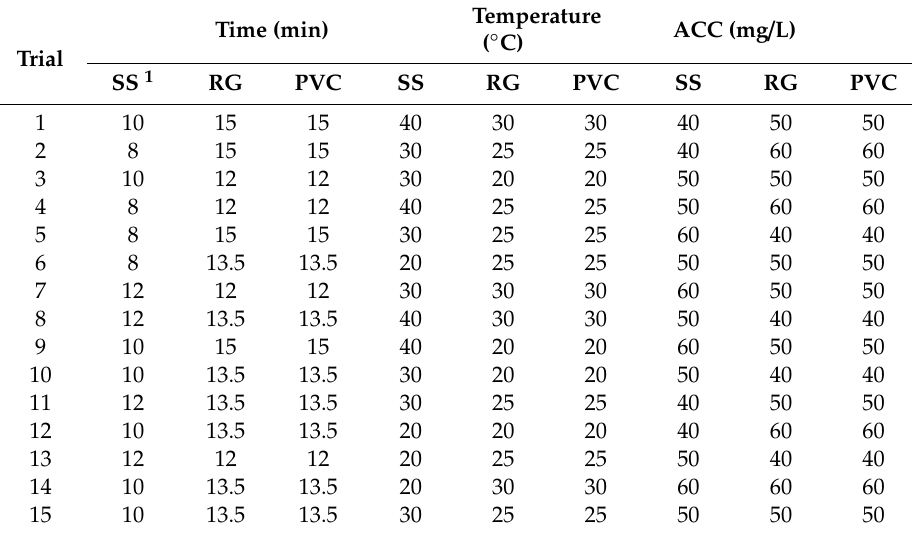
Table 1. Box–Benken response surface design.